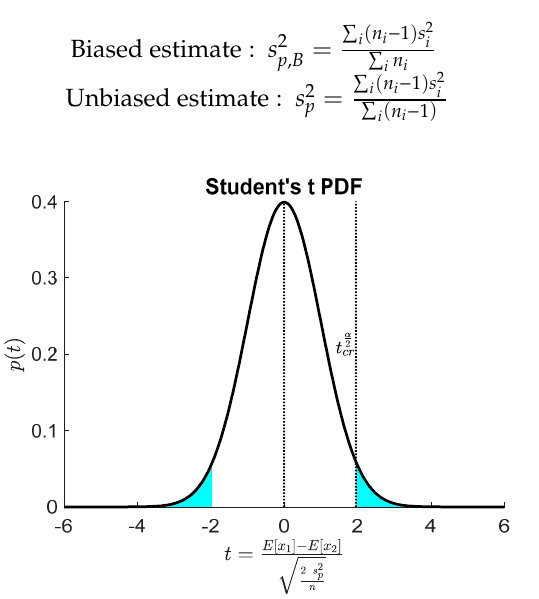
Table 7. Statistical summary of the sample as a function of the population distribution and numerousness 𝑛 of the sample.